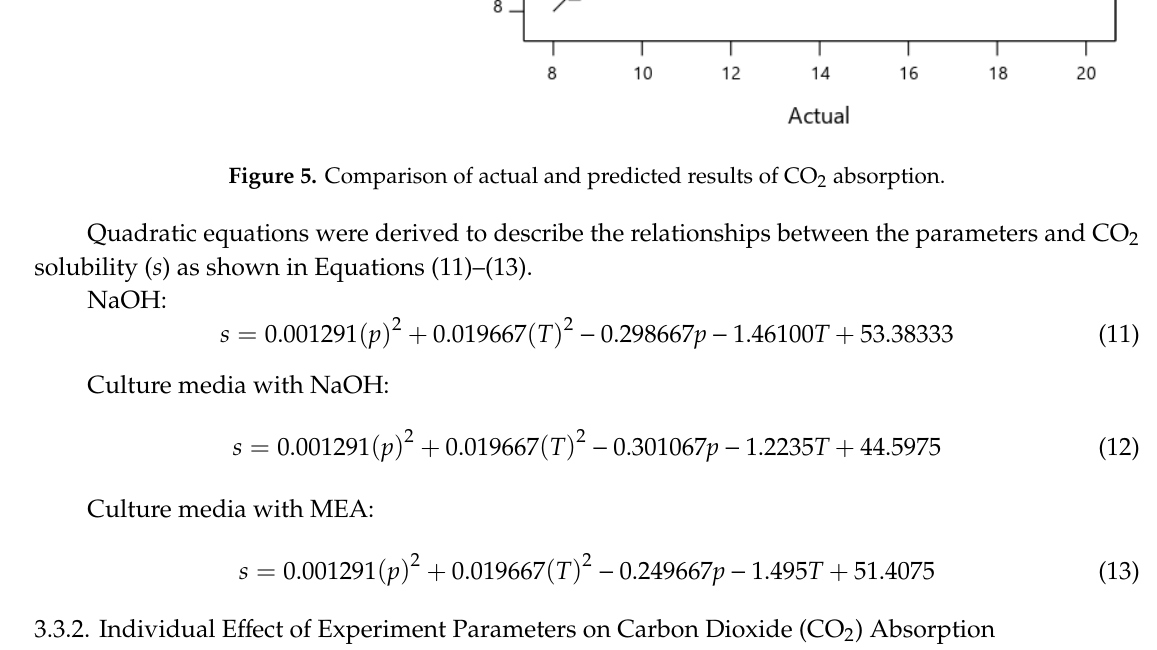
The significance of each parameter on CO 2 solubility can be illustrated by the perturbation plot in